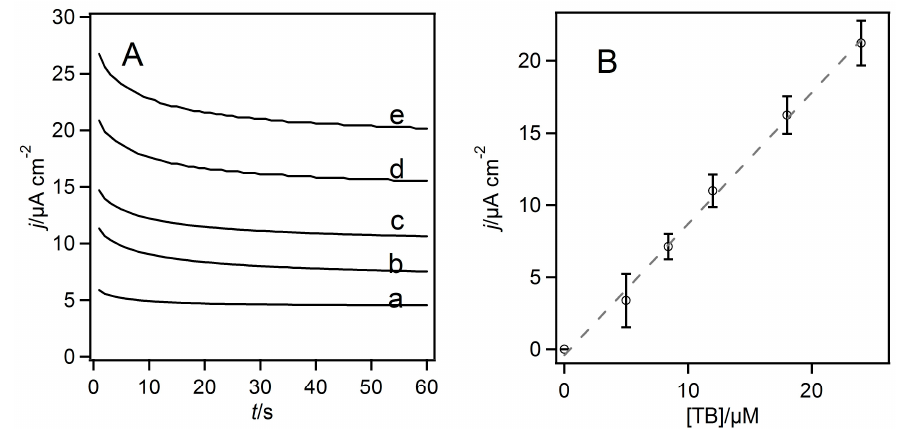
Figure 2. ( A ) Dependence of the current density on the constant potential electrolysis time for various toluidine blue (TB) concentrations; curves (a) 5.0 μ M, (b) 8.4 μ M, (c) 12 μ M, (d) 16 μ M, and (e) 24 μ M TB; ( B ) Dependence of the steady-state catalytic current on the TB concentration. The error bars were evaluated by a Student’s t -distribution at a 90% confidence level. Dashed lines represent the regression line considering the weight of the error.